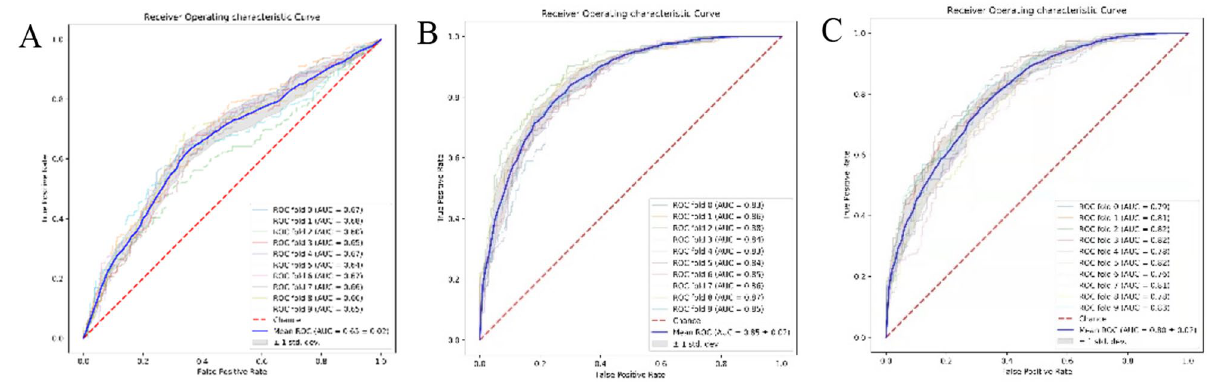
Figure 3. Receiver operating characteristic curves showing the performance of ( A ) LR (a combination of 15 indicators), ( B ) XGBoost (15 indicators), and ( C ) XGBoost (5 indicators) in predicting COVID-19 malignancy. AUC: area under the curve, LR: logistic regression, XGBoost: extreme gradient boosting.